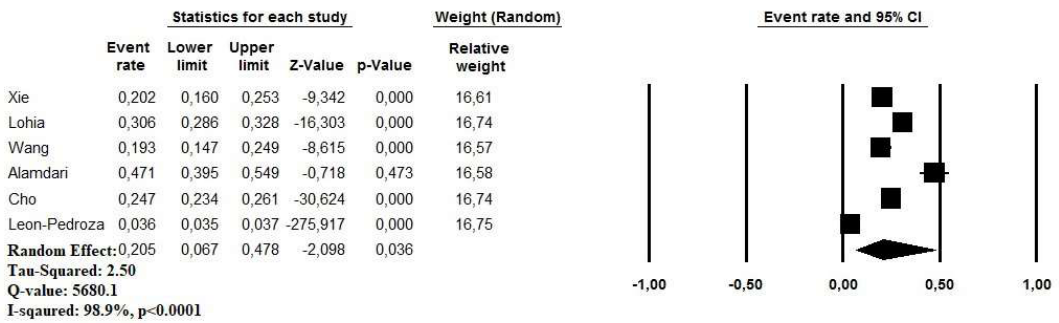
Figure 2. Pooled prevalence of pre-existing metabolic syndrome in COVID-19 patient.